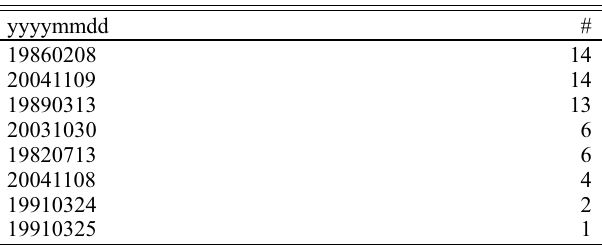
Table 3. Days on which the 1-h time series of spot readings at 1975–2012. The number of maxima on the particular day is also